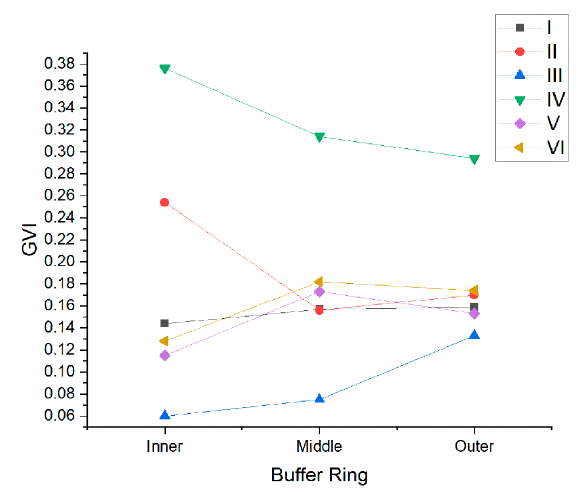
Figure 9. GVI variation trend from the inner ring to the outer ring in 6 spots (I–VII). The horizontal axis represents three buffer rings. The vertical axis represents the average GVI in each ring.